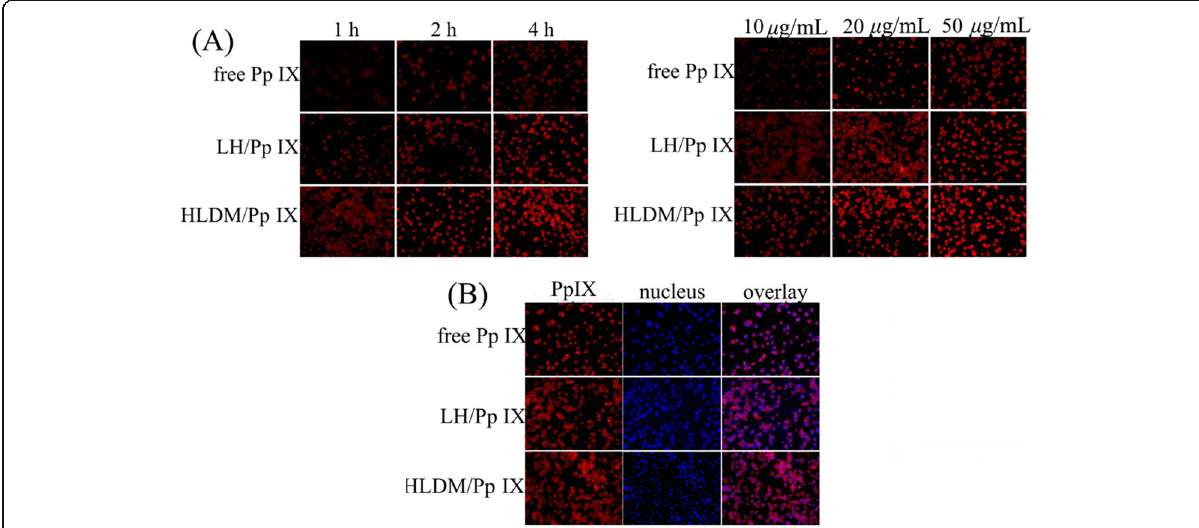
Fig. 6 a Uptake of free Pp IX, Pp IX-loaded LH, and Pp IX-loaded HLDM micelles. b Cell location of Pp IX-loaded HLDM micelles